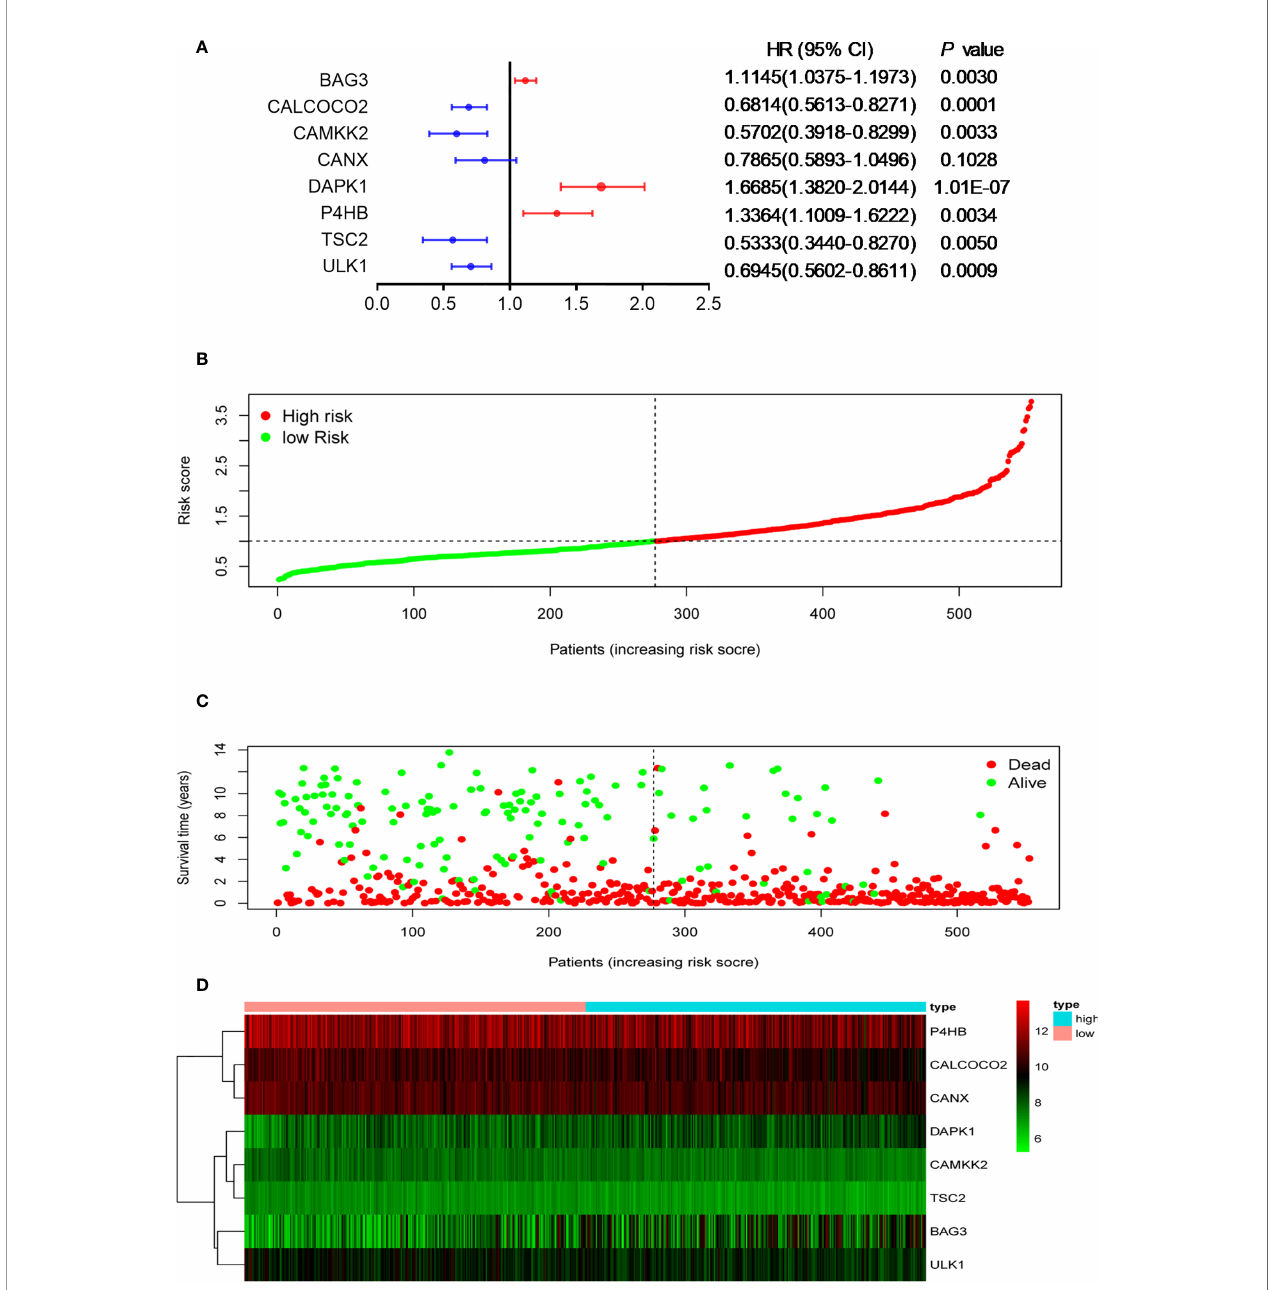
FIGURE 2 | Development of the prognostic signature based on OS-relevant ARGs. (A) . The hazard ratio of model genes. (B) Distribution of the patients ’ risk scores. (C) Patients ’ survival times along with their risk scores. (D) The expressions of the eight model genes in the high- and low-risk